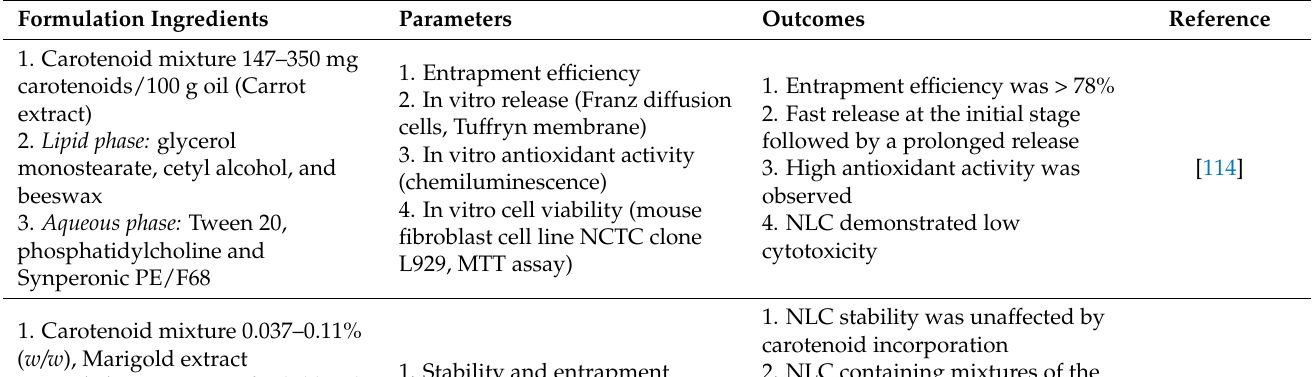
Table 3. Studies on carotenoid encapsulation in nanostructured lipid carriers (NLC) employing high-pressure homogeniza- tion as the preparation